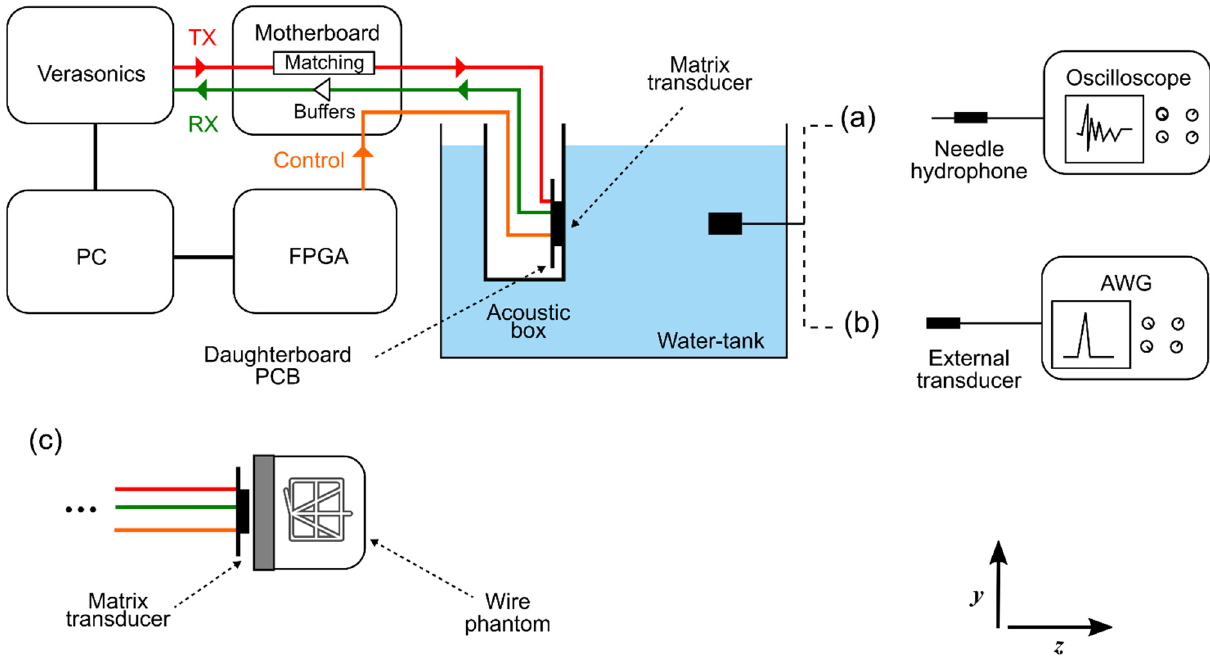
Figure 6. Acoustical measurement setup. ( a ) Transmit characterization. ( b ) Receive characterization. ( c ) Imaging using a CIRS phantom.